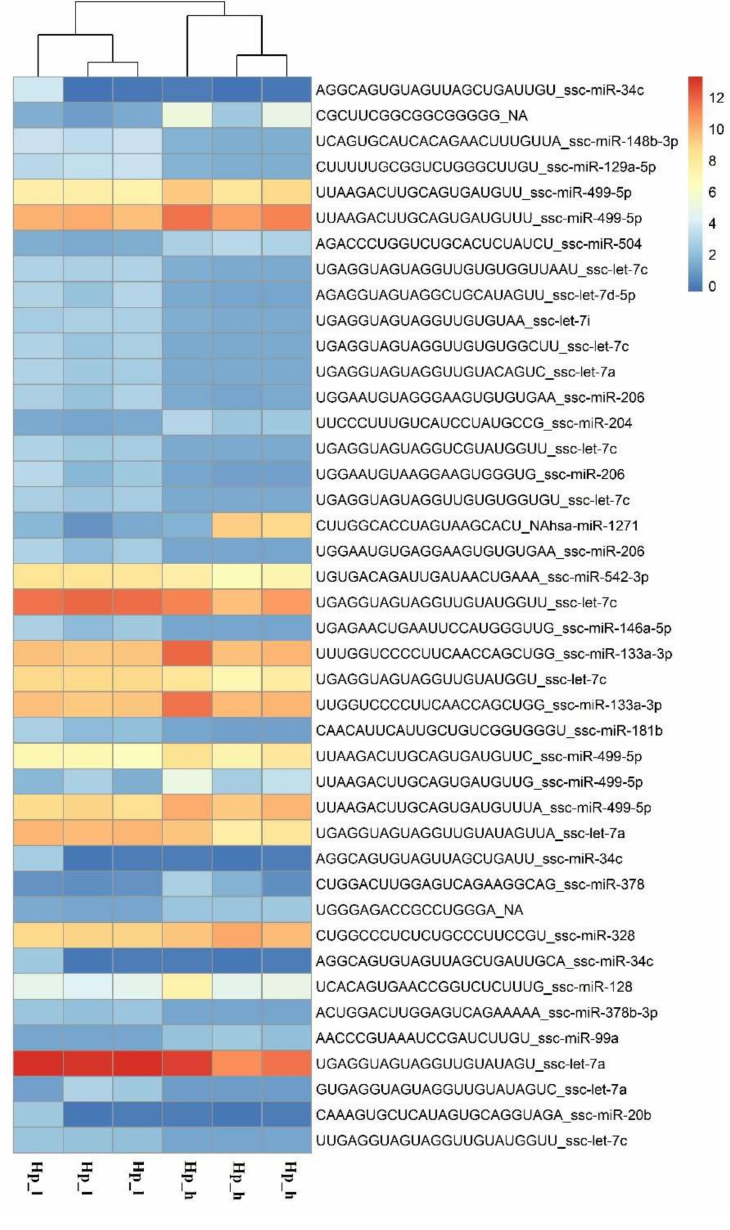
Figure 4. Theexpressionpatternobtainedforthemostsignificant( p <0.01)miRNAsdetectedintheHampshire breed in pig groups differed in muscle weight (h, l,—high or low muscle mass) (R Package pheatmap). Eighteen DE microRNAs detected in both breeds were further subjected to Gene Ontology and KEGG Pathway analyses (mirPath v.3.0, DIANA-Lab, Athens, Greece). According to an experimentally validated target gene database (Tarbase v7.0, (DIANA-Lab, Athens, Greece)), the most over-represented GO processes were identified, such as cell cycle, fatty acid biosynthesis, regulation of actin cytoskeleton as well as lysine degradation and ubiquitin mediated proteolysis (Table 2). All identified GO biological processes related to 18 DE microRNAs are shown in Figure 5. The GO terms in each breed and taking into account the direction of expression change is presented in Figures